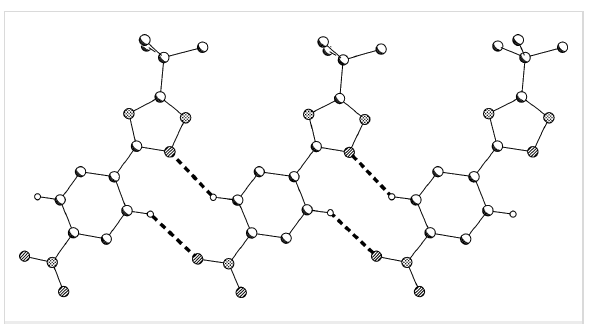
Figure 5: Molecular structure of 3- tert -butyl-5-(4-nitrophenyl)-1,2,4- oxadiazole ( 2 ). Atoms are drawn as 50% thermal ellipsoids.